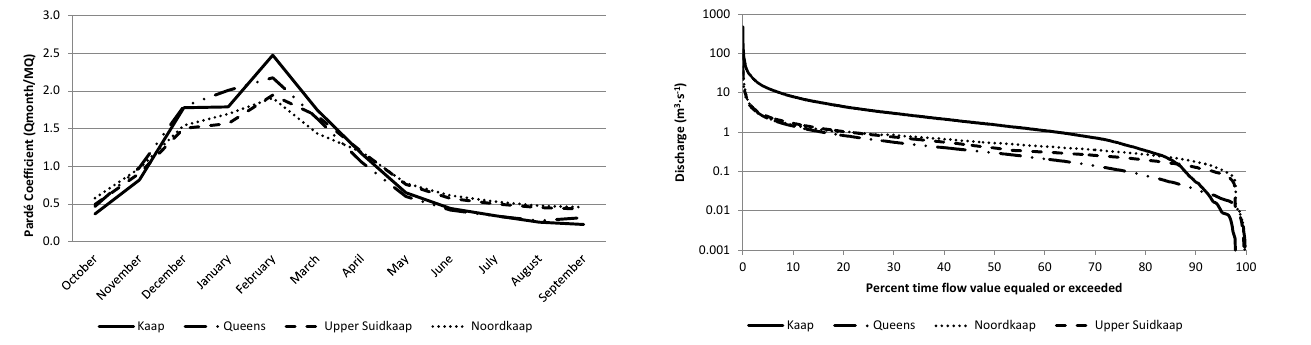
Figure 4. Annual flow regimes at X2H022 (outlet), X2H008 (Queens), X2H031 and X2H024 (Suidkaap) and X2H010 (Noord- kaap) based on long-term flow data.